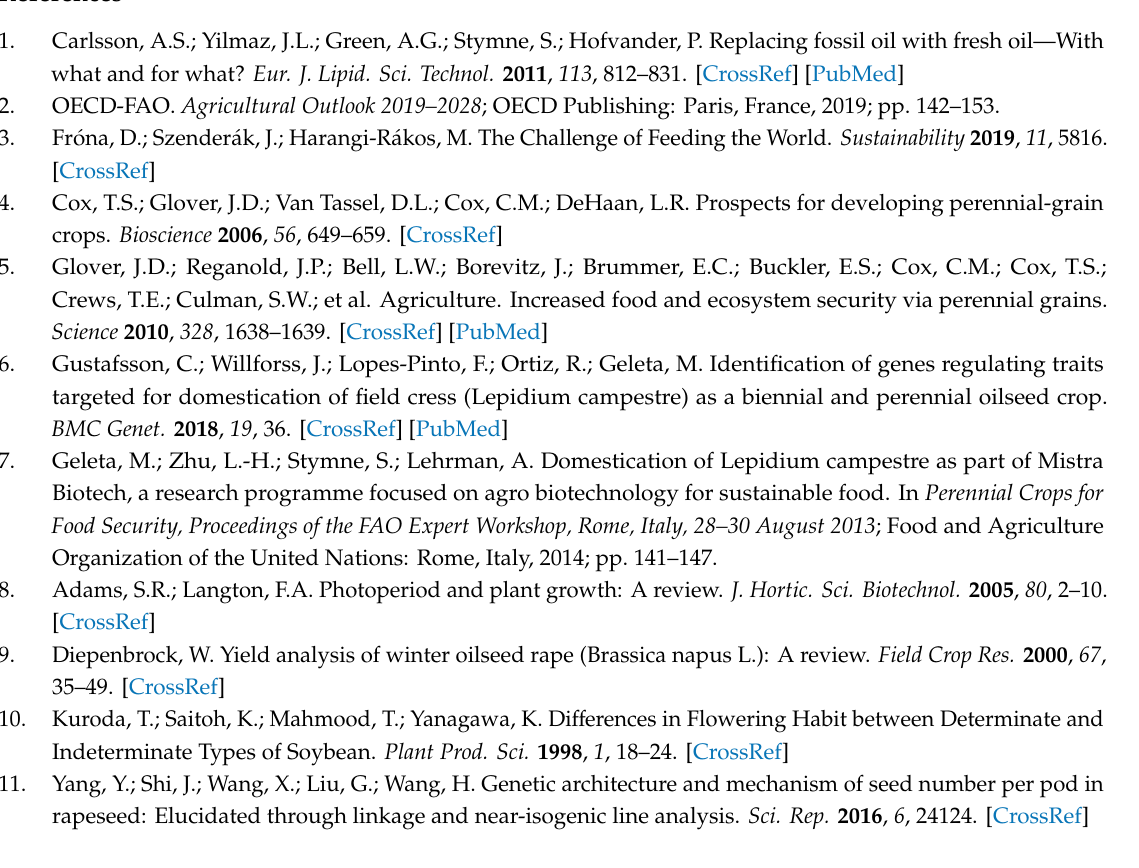
Figure S1: Plant pictures showing desirable and undesirable characteristics of the studied traits. Table S1: (A) list of the 2330 mapped SNPs on 1044 contigs / sca ff olds. The contigs / sca ff olds containing these mapped SNPs can be found within the accession WJSH00000000 at the DDBJ / ENA /